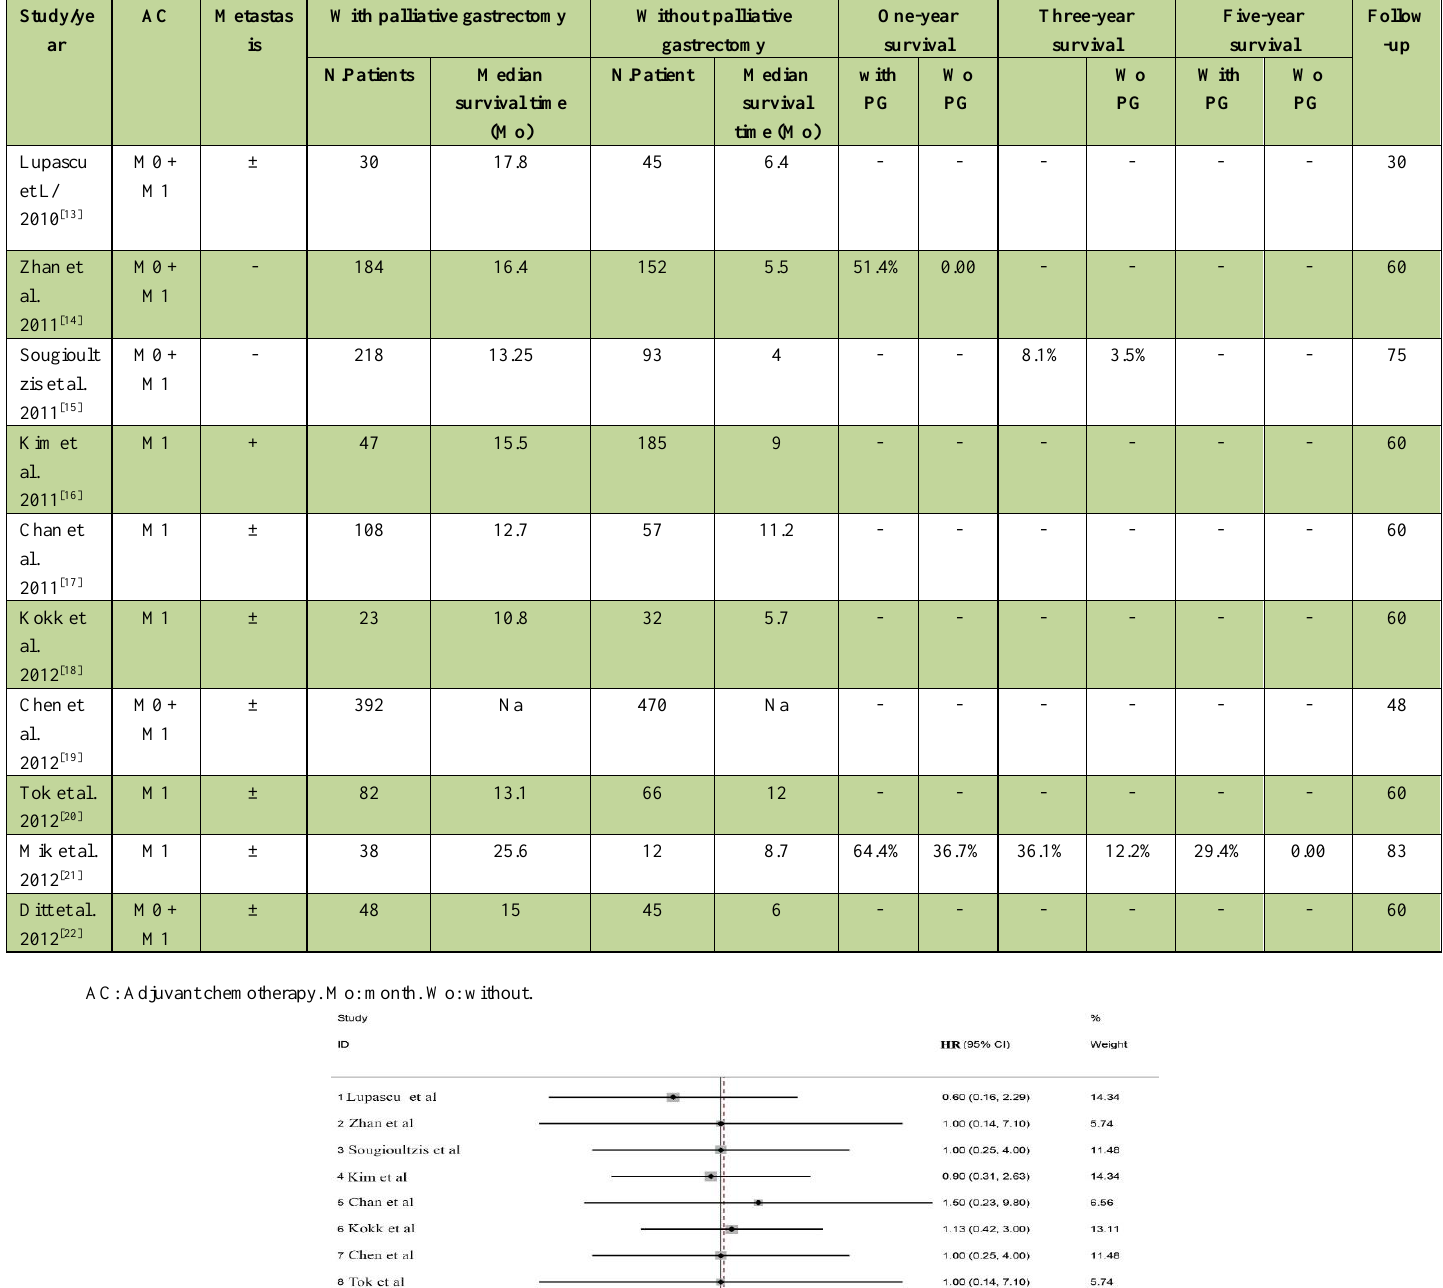
Table 1. Studies selected for Systematic Review and Meta-analysis for Palliative gastrectomy.